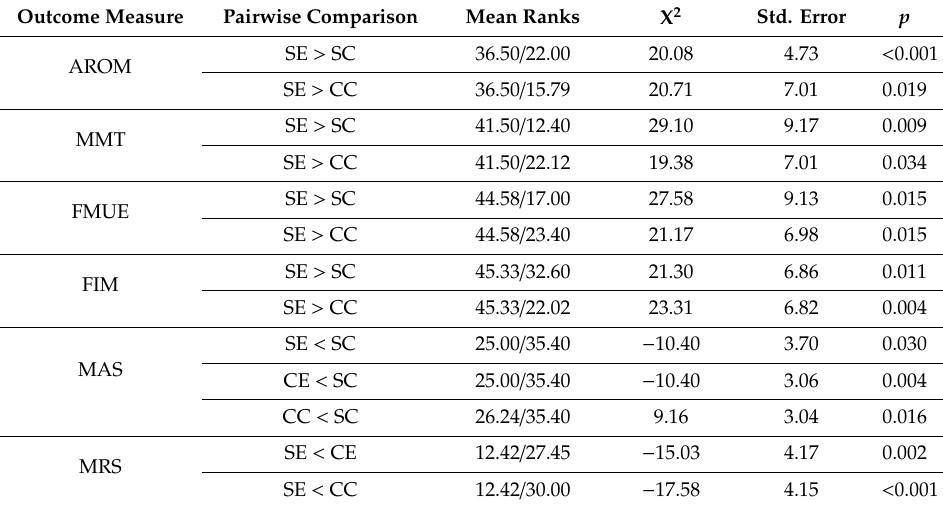
Table 4. Post hoc pairwise comparison for independent